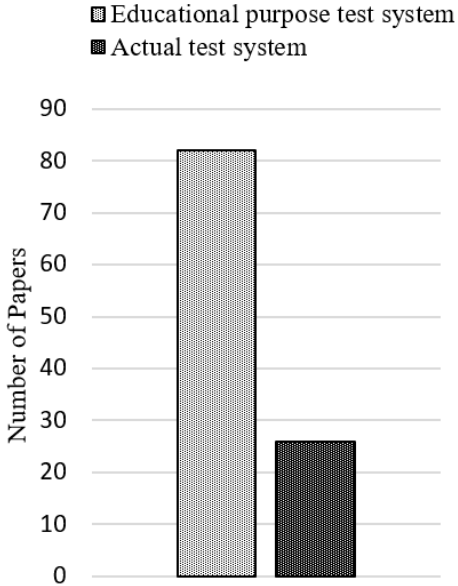
Figure 5. Category of the test systems used in literature.